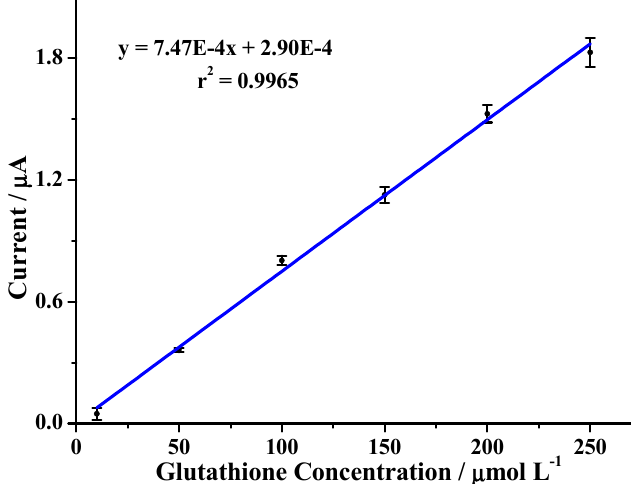
Figure 5. Calibration curve for reduced glutathione on Pt working electrode.